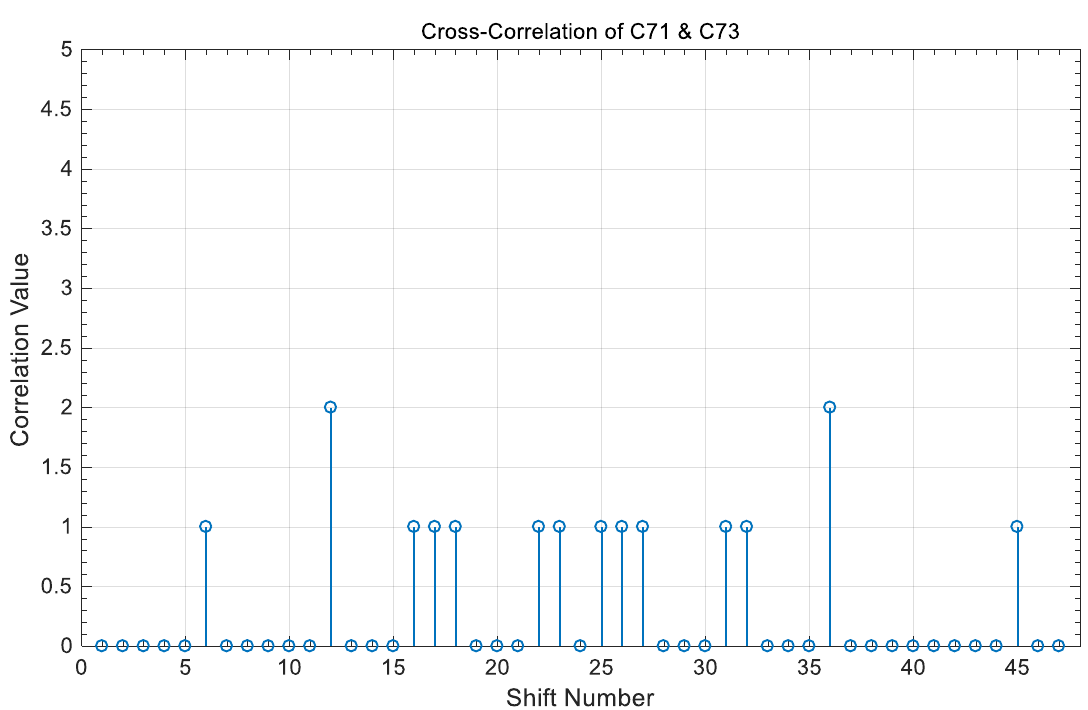
Figure 10. Cross-correlation between 𝐶 71 and 𝐶 73 sequences in same group, 𝑃 1 = 5 and 𝑃 2 = 7.